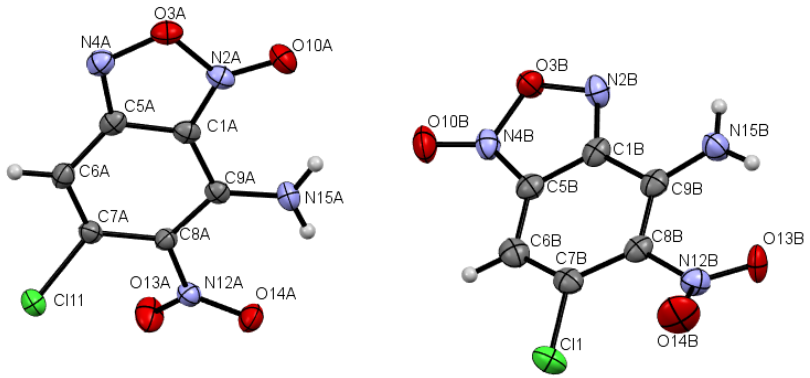
Figure 3. Asymmetric unit of tautomers 3A and 3B showing 50% probability thermal ellipsoids. C